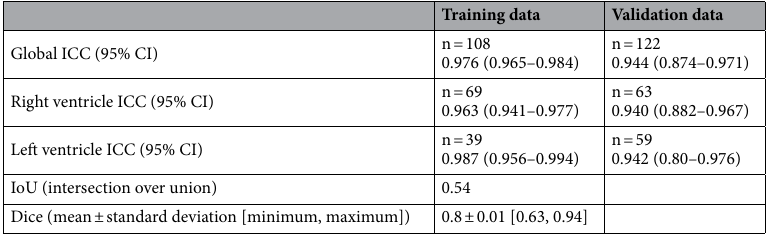
Table 2. Reliability of the automated segmentation compared to manual segmentation (“gold standard”) measured by the intraclass correlation coefficient (ICC).